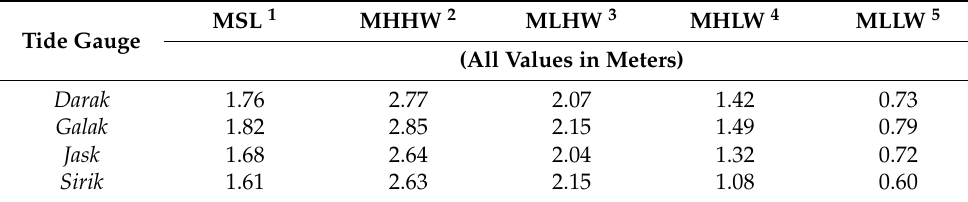
Table 2. Sea level and tidal information for the study